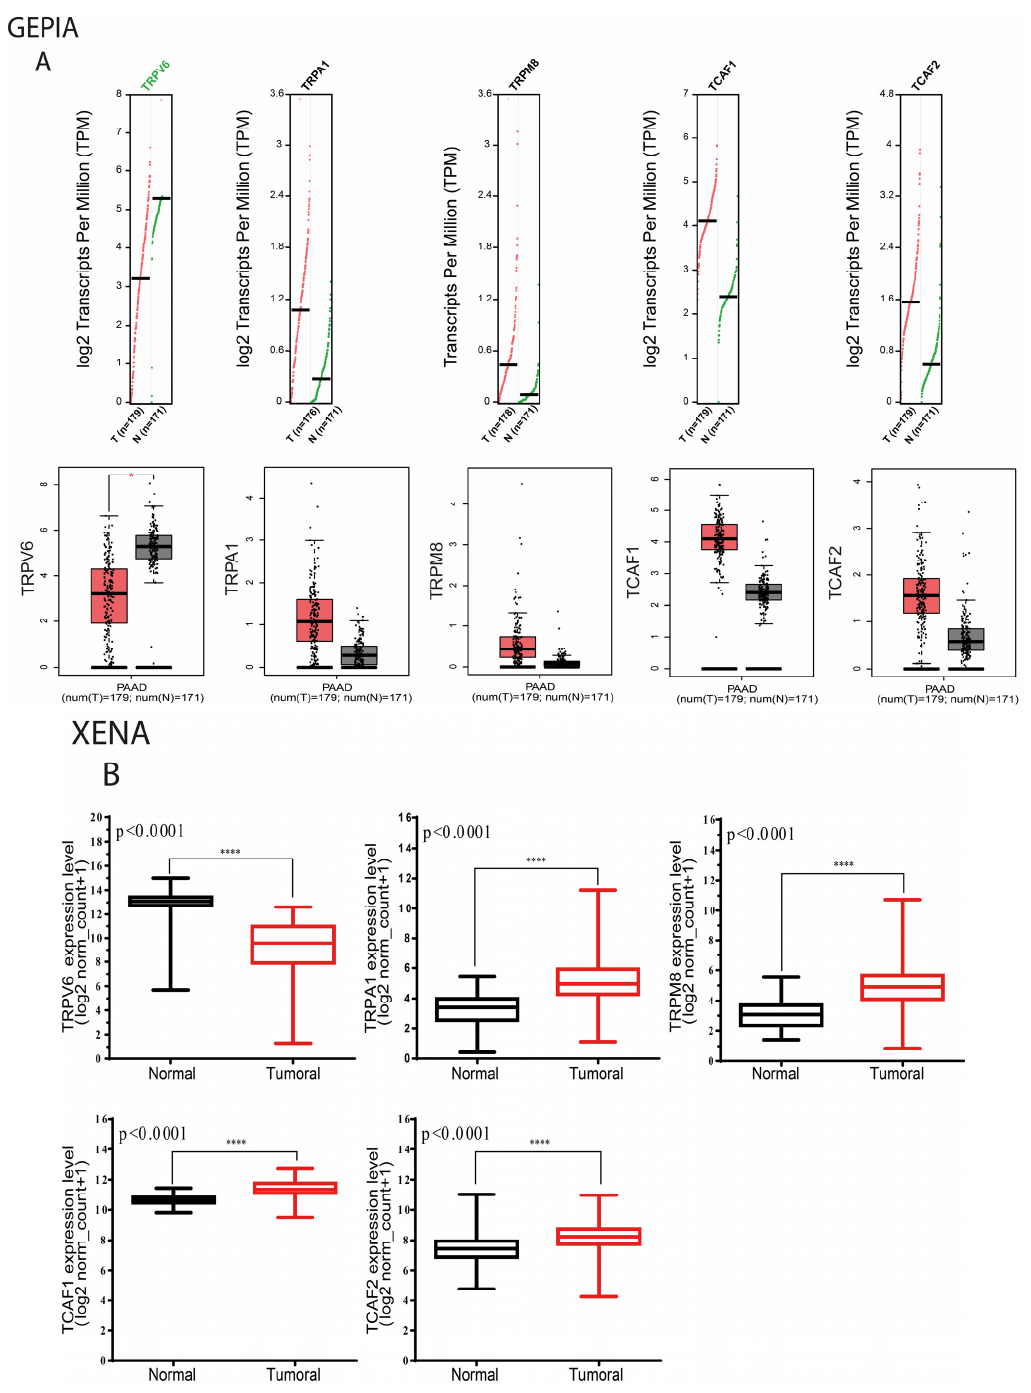
Figure 1. Differential mRNA expression levels of, TRPV6, TRPA1, TRPM8, TCAF1, and TCAF2 in PDAC patients from public datasets. ( A ). mRNA expression levels for PDAC patients analyzed with GEPIA (red for tumor (n = 179), black for normal (n = 171)) ( B ). mRNA expression levels for PDAC patients analyzed with XENA (red for tumor, black for normal). The first and third quartiles are represented by the upper and lower horizontal lines of the box, the median by the center horizontal line, and the maximum and minimum values by the whiskers. * p < 0.05, **** p < 0.0001. We also noticed that TRPV6 expression was lower in tumoral tissues than in normal tissues when we applied the multiple gene comparison matrix plot from GEPIA. Moreo- ver, out of all the TRP genes analyzed, TRPV6 had the highest expression level (Figure 2).